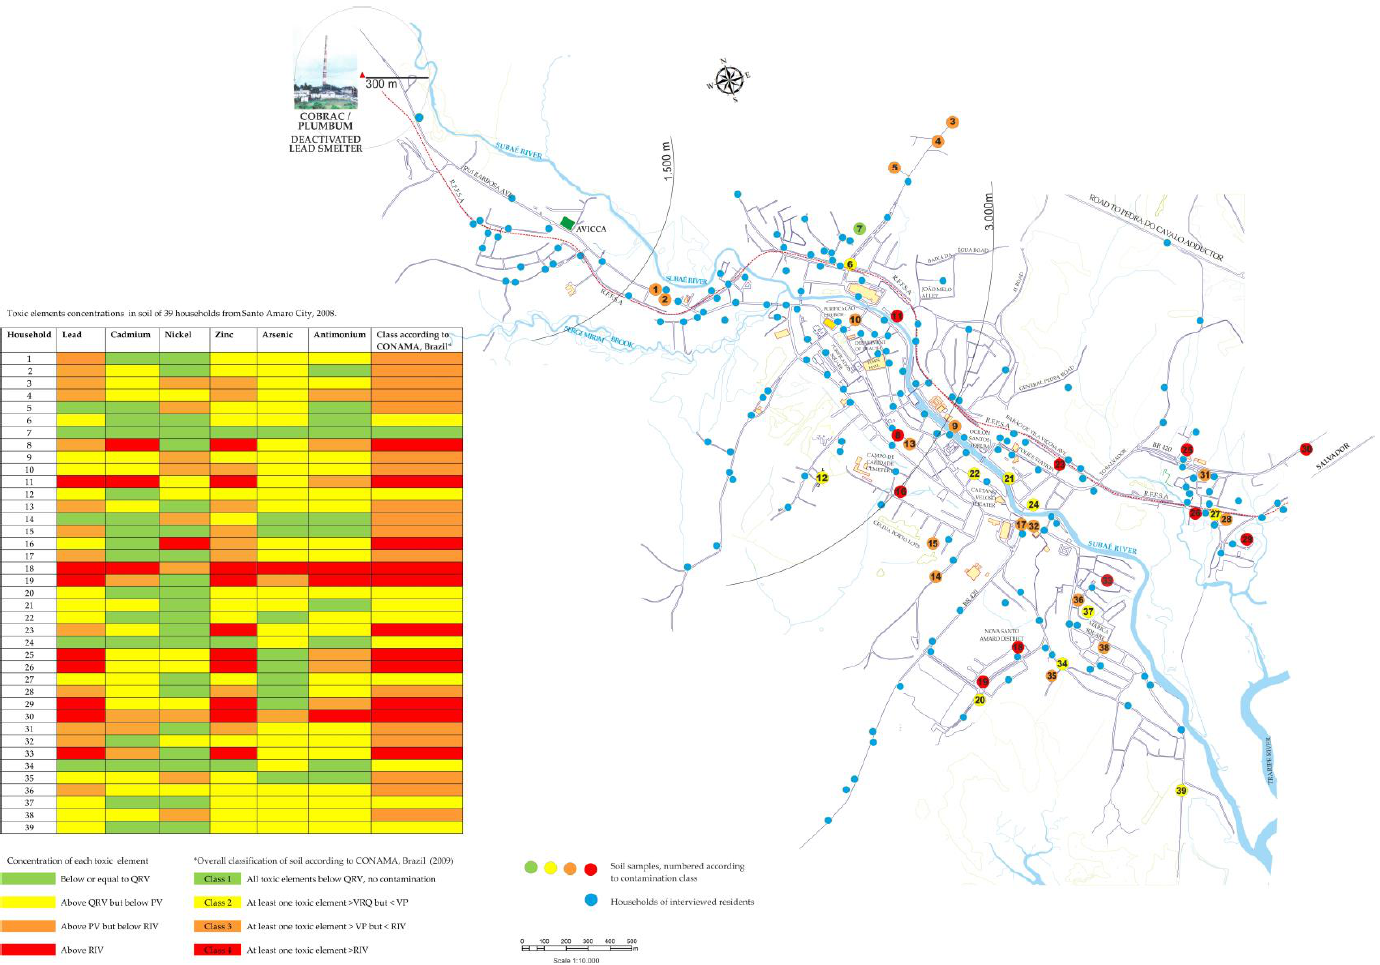
Figure 5. A map of Santo Amaro City showing the deactivated lead smelter, the 208 households investigated, including the 39 households from where soil samples were analyzed for chemical element concentrations and classified according to Brazilian quality standards, 2008.